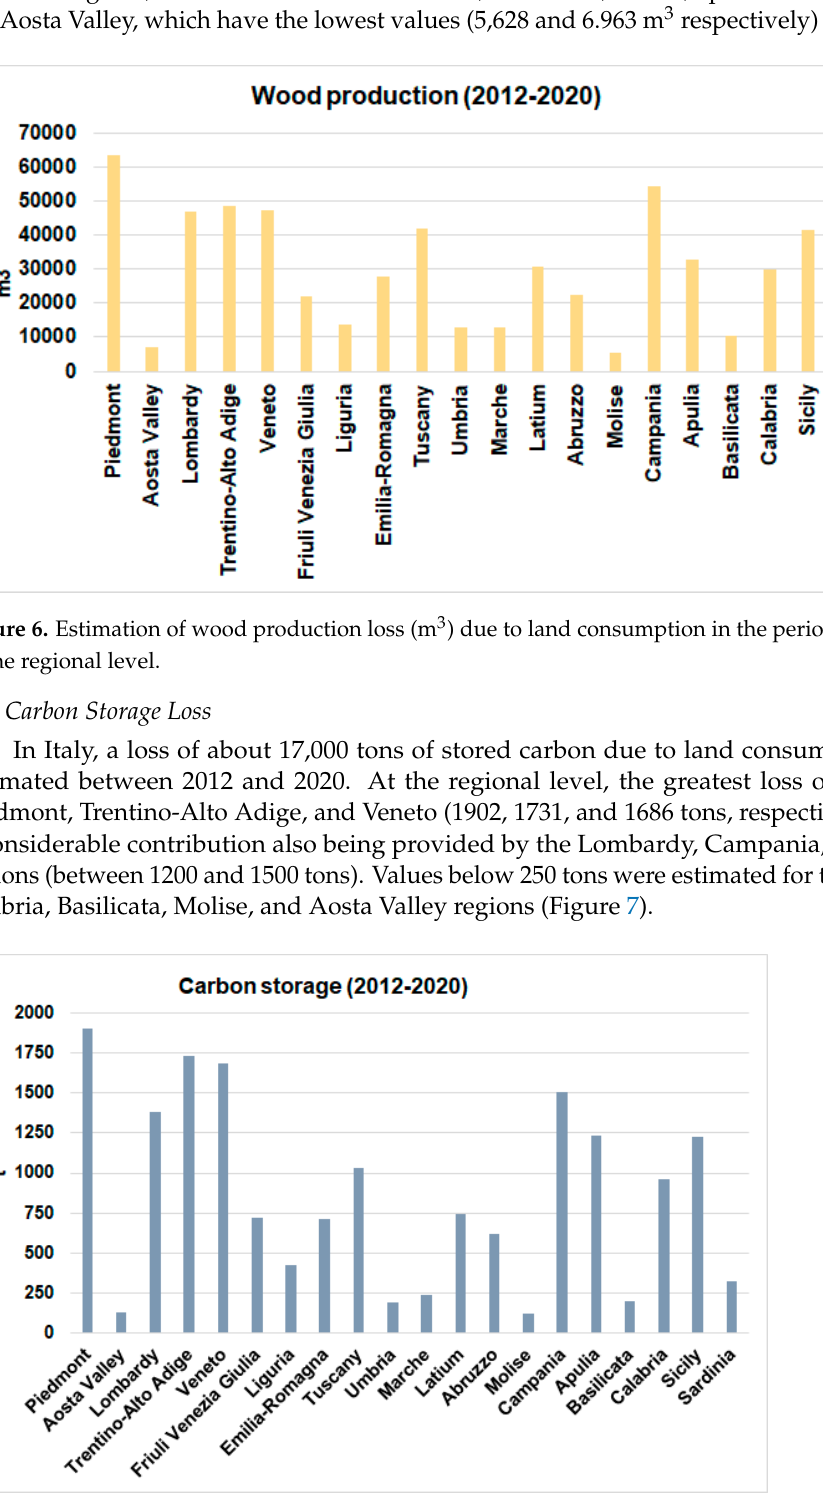
Figure 5. Estimation of crop production loss (quintals) due to land consumption for five agricultural classes in the period 2012–2020 at the regional level.